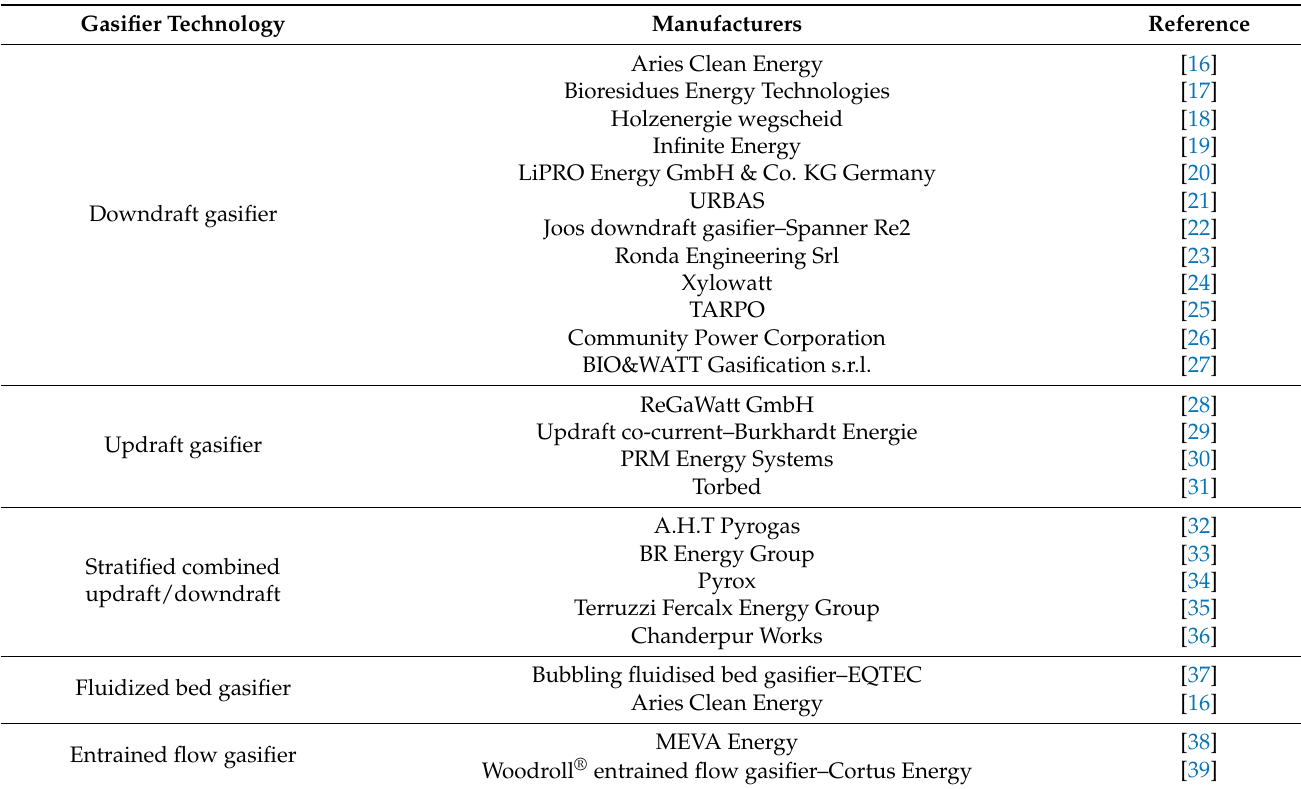
Table 2. Examples of manufacturers of key gasifier technology